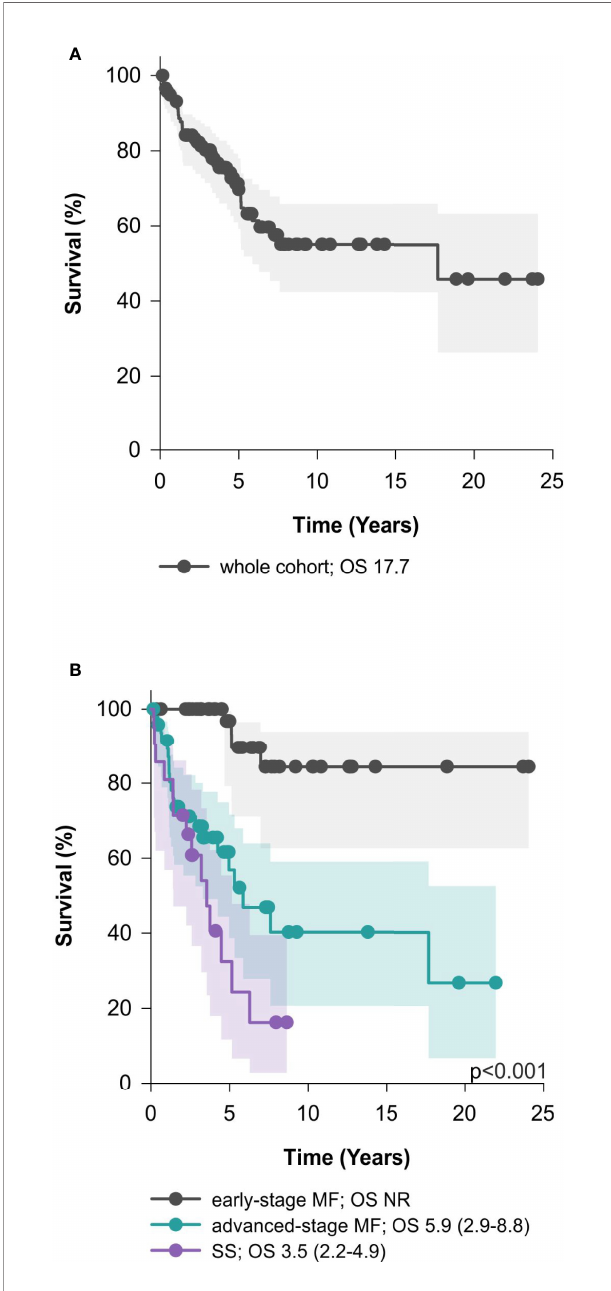
FIGURE 2 | Survival parameters of the whole cohort – median overall survival (95% con fi dence interval). (A) Median Overall survival of the whole cohort; (B) median overall survival of early-stage MF, advanced- stage MF, and SS. MF, mycosis fungoides; SS, Se ́ zary syndrome; OS, median overall survival; NR, not